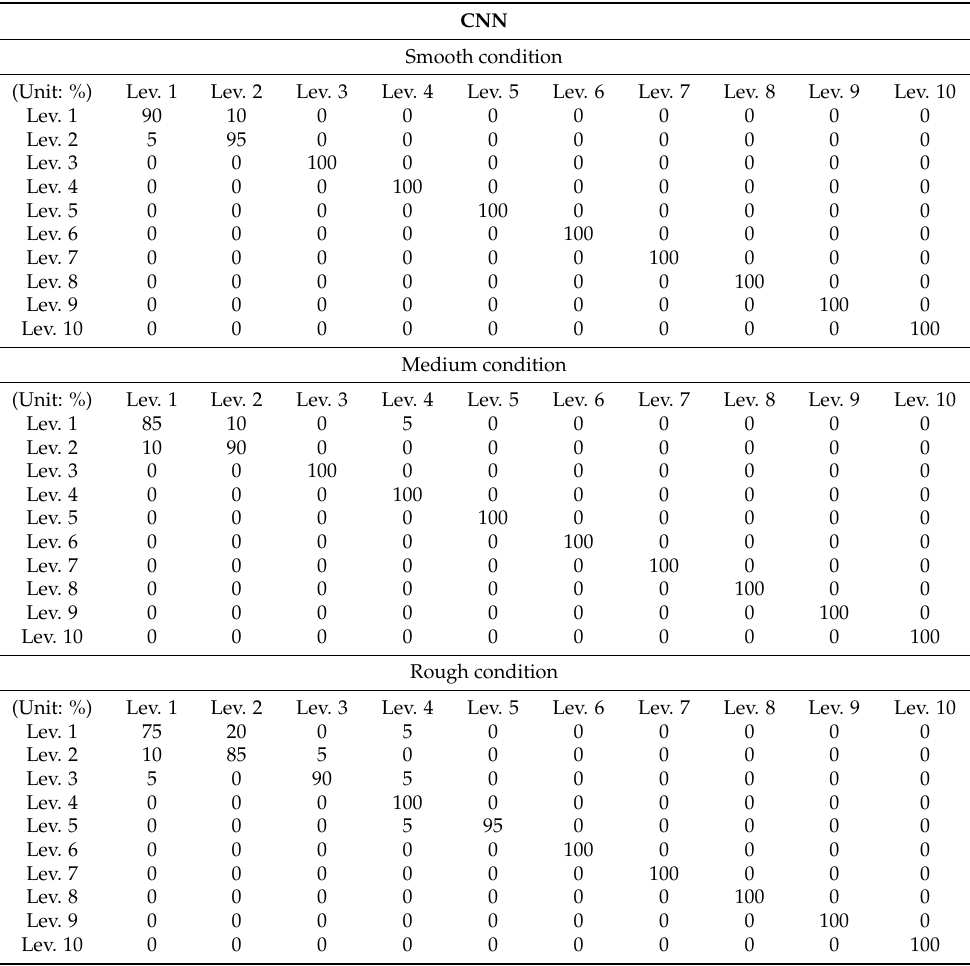
Table A1. Confusion matrices for the CNN model in three surface conditions.